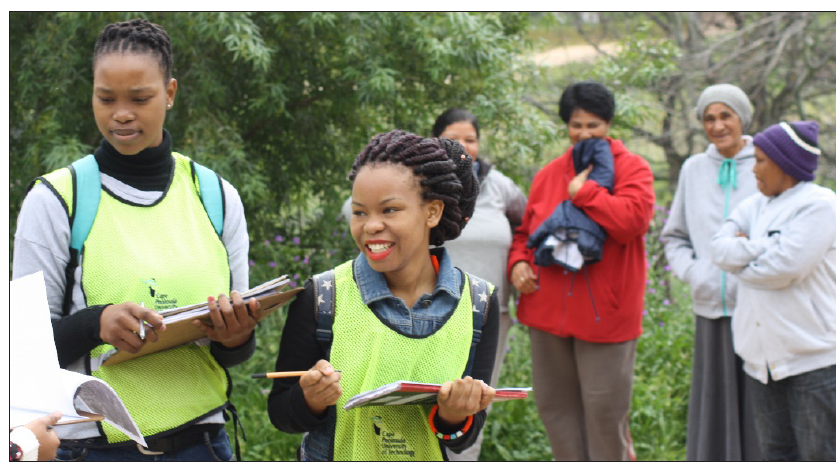
CPUT students with Goedverwacht residents collaborate in the mapping